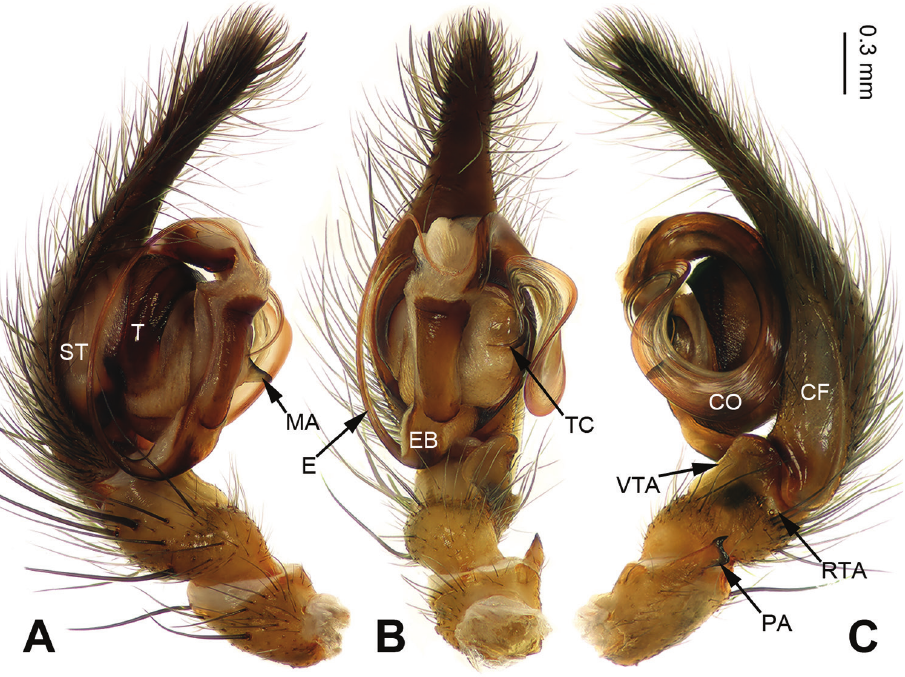
Figure 7. Palp of Pireneitega triglochinata , specimen from Mt. Emei. A Prolateral view B Ventral view C Retrolateral view. Scale bar: equal for A, B, C . 12.45 (3.75, 4.10, 3.00, 1.60); IV: 16.30 (4.75, 5.25, 4.30, 2.00). Carapace brown, radial grooves indistinct. Abdomen yellow with black herringbone pattern. Palp as in Fig. 7: patellar apophysis long, more than half length of tibia, with tapering tip; tibia short, about the same length as cymbium; VTA subequal to the tibial length, without pointed tip, extending beyond the tibia; RTA short, about 1/8 length of VTA; cymbial furrow short, about 1/3 length of cymbium; width of conductor about 1/5 of loop diameter; embolus with broad base, beginning at the 6:00 o’clock position.